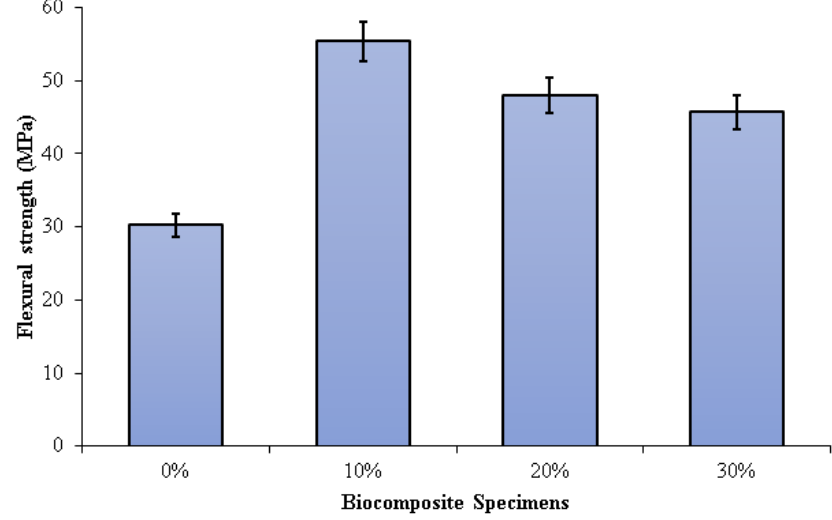
Figure 7. Flexural strength of PLA/PCL/nHA biocomposite specimens. Flexural strengths of 0%, 10%, 20%, and 30% of specimens were 30.21 MPa, 55.35 MPa, 47.99 MPa, and 45.67 MPa, respectively. The highest flexural strength (55.35 MPa)